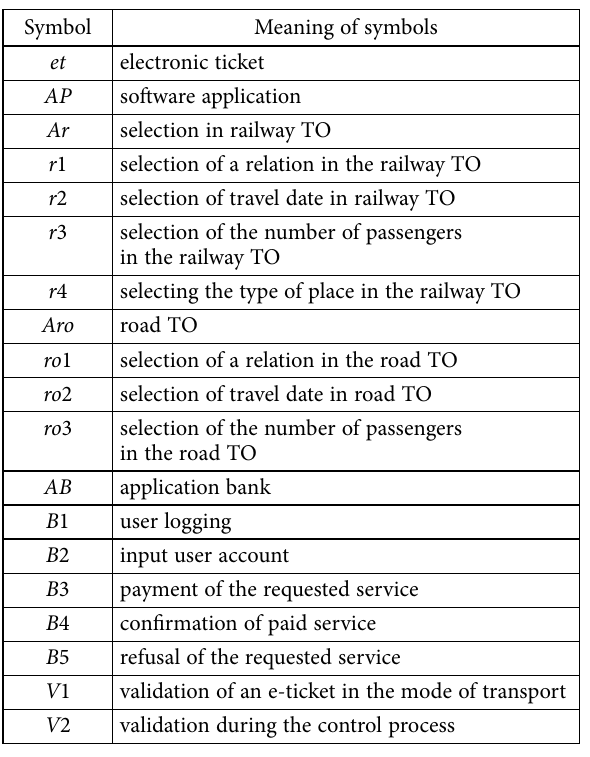
Table 3. The overview and the meaning of the symbols that are applied in the algorithm